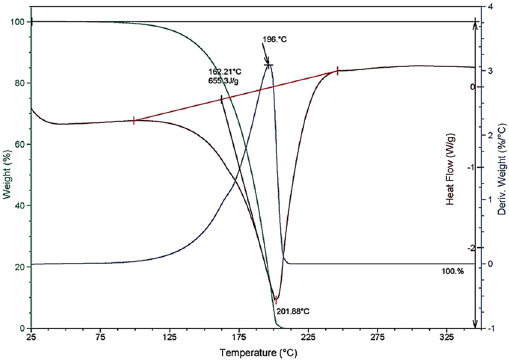
Figure 1. DTA/TGA profiles of the formulation nicotine (2.1 wt%) in